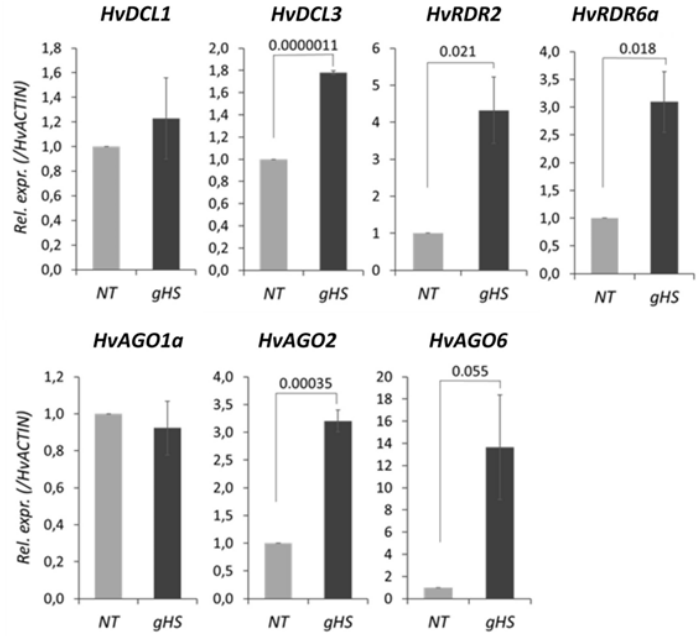
Figure 9. RNA-seq analysis of the data published by Pacak et al. [79]. ( A ) Heat map representation of the expression pattern of silencing-related genes in heat-shocked (HS) and not treated (NT) barley plants (data for the three biological replicates are shown separately). Colours represent Z -scores, which show how many standard deviations the given value is above or below the mean of all values in a row. Genes that are significantly differentially expressed between the NT and HS samples are marked with asterisks. ( B ) Bar chart representation of the expression values of the significantly differentially expressed RNA silencing-related genes. Expression values are normalised transcript per million (TPM) units. Error bars represent standard errors.